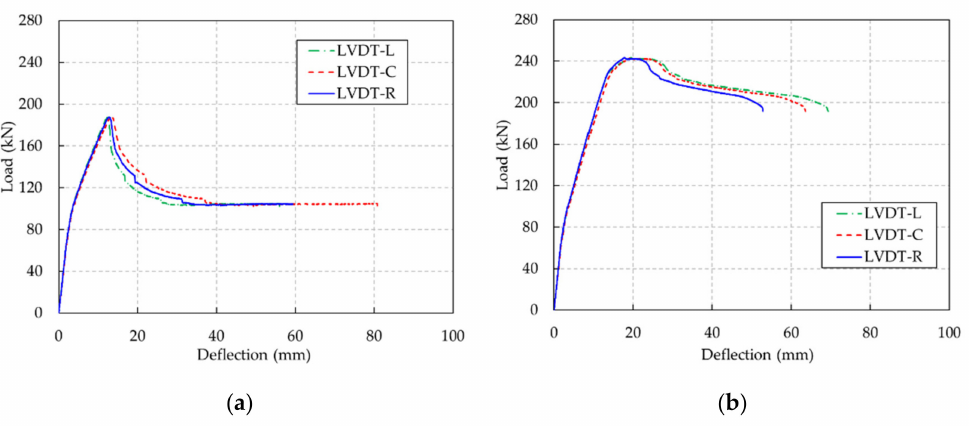
Figure 14. Load-deflection curves obtained by three di ff erent LVDTs. ( a ) UHPC-F15-R1 beam, ( b ) UHPC-F15-R3 beam.